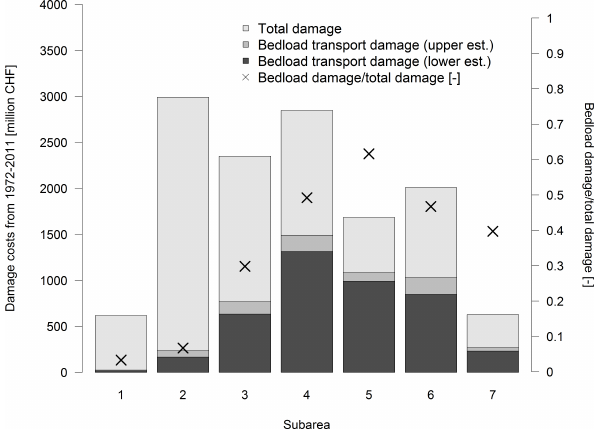
Fig. 4. Total damage costs and damage costs by bedload transport for the seven subareas (Fig. 1; Table 1) over the 40yr study pe- riod. Crosses indicate the ratio of costs caused by bedload trans- port processes (mean of the two estimates) to total costs. Note that CHF145–165 million of losses could not distinctively be assigned to a